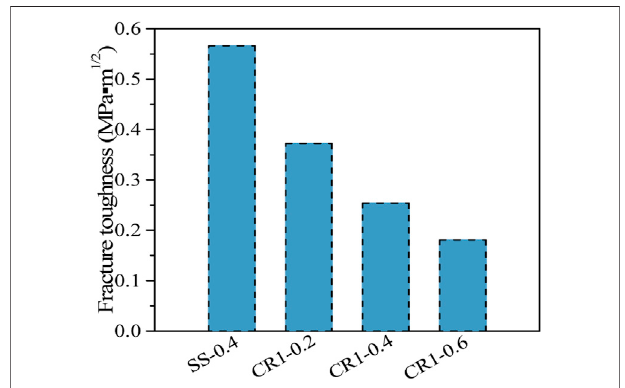
FIGURE 4 | Fracture toughness of HS-ECC. HS-ECC, high-strength engineered cementitious composite.